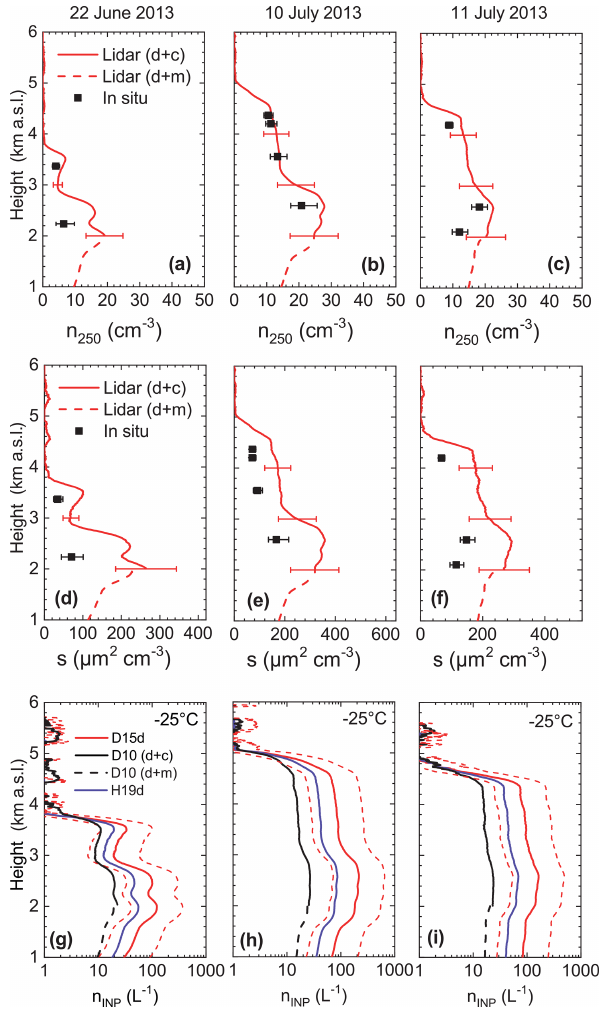
Figure 4. Number concentration n 250 for particles with a radius of more than 250nm (a–c) and surface-area concentration s (d– f) measured aboard the Falcon aircraft (black squares) and de- rived from the lidar measurements (red profiles; solid line – sum of dust and continental pollution particles above 2km; dashed line – sum of dust and marine particles below 2km). The three SALTRACE case studies are shown: 22 June ( a, d, g ), 10 July ( b, e, h ), and 11 July 2013 ( c, f, i ). INP concentrations (g–i) are given at − 25 ◦ C for the immersion-freezing parameterizations of D10d + c (input n 250 , d + n 250 , c ; above approx. 2km), D10d + m (input n 250 , d + n 250 , m ; below approx. 2km), D15d (input n 250 , d ), and H19d (input s d ; see Table 2). The 1% K-feldspar contribution was used for H19d. The uncertainty in the lidar-derived n 250 and s values is 30%. For the INP concentration an uncertainty of a fac- tor of 3 is indicated by the dashed lines for the D15d profile. The error bars of the in situ measurements indicate the 16th and 84th percentile.